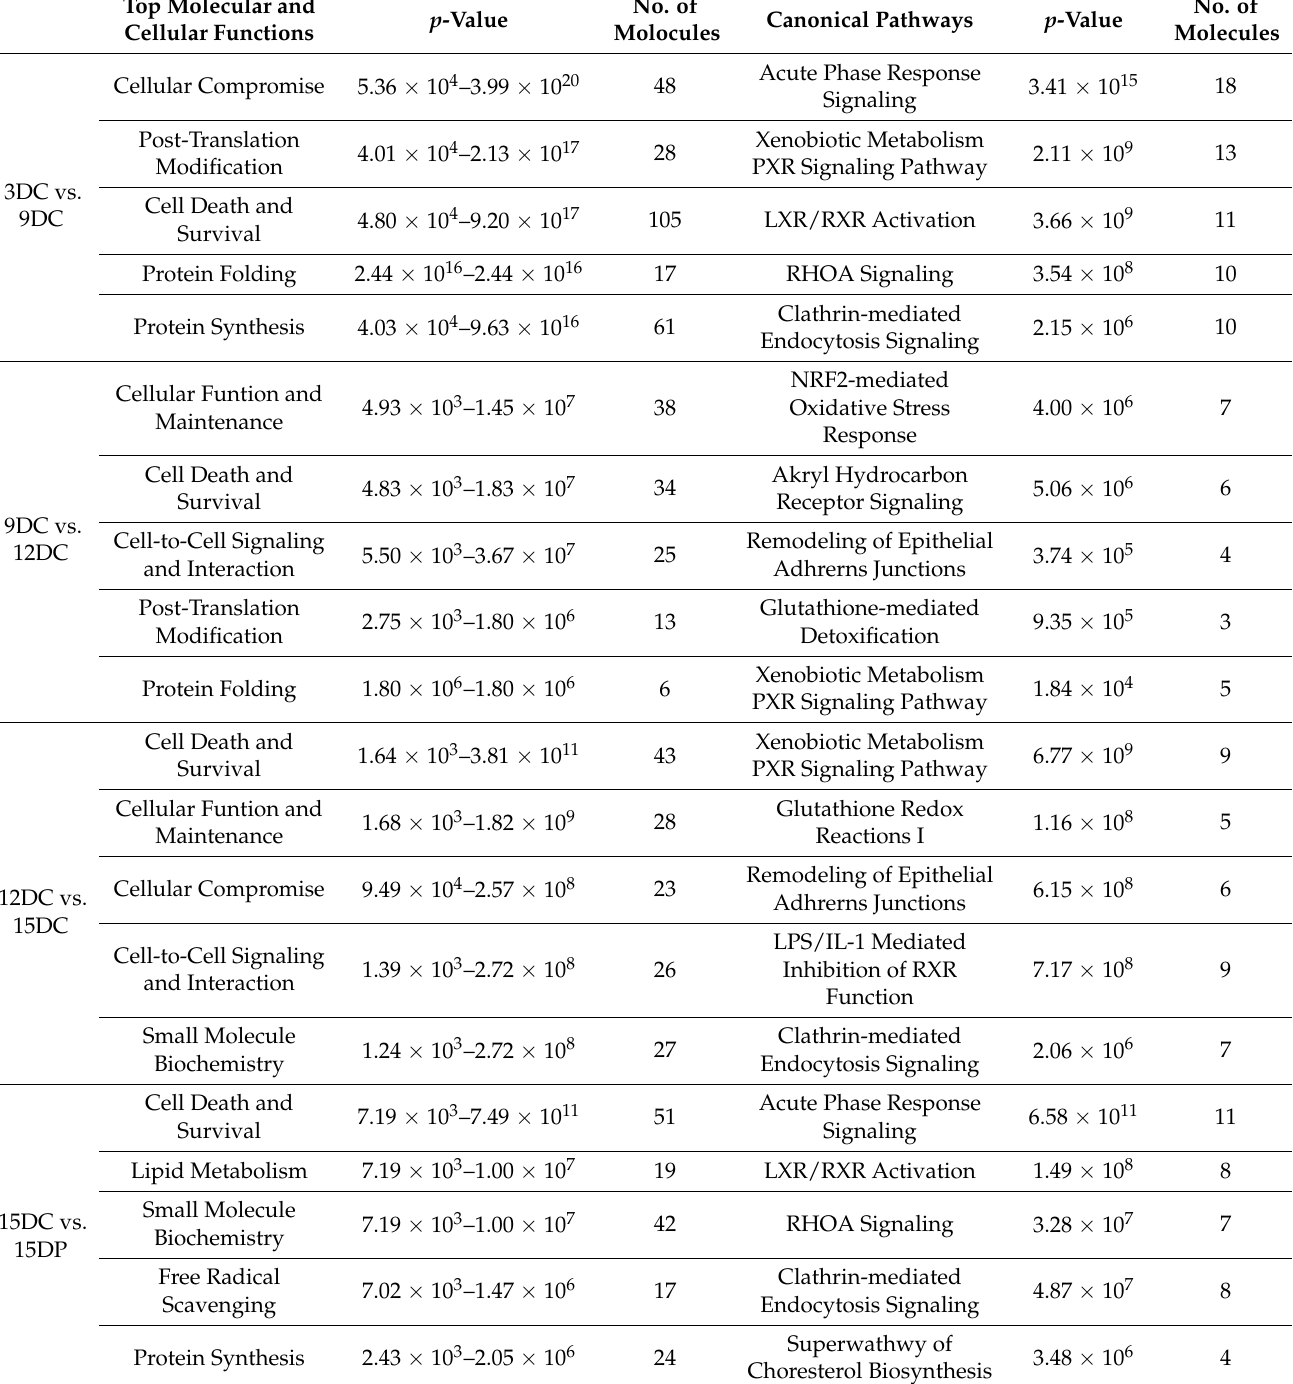
Table 1. IPA analysis overview: top molecular and cellular functions, and canonical pathways associated with differentially regulated proteins between various comparisons: 3DC vs. 9DC, 9DC vs. 12DC, 12DC vs. 15DC, and 15DC vs. 15DP. Top Molecular